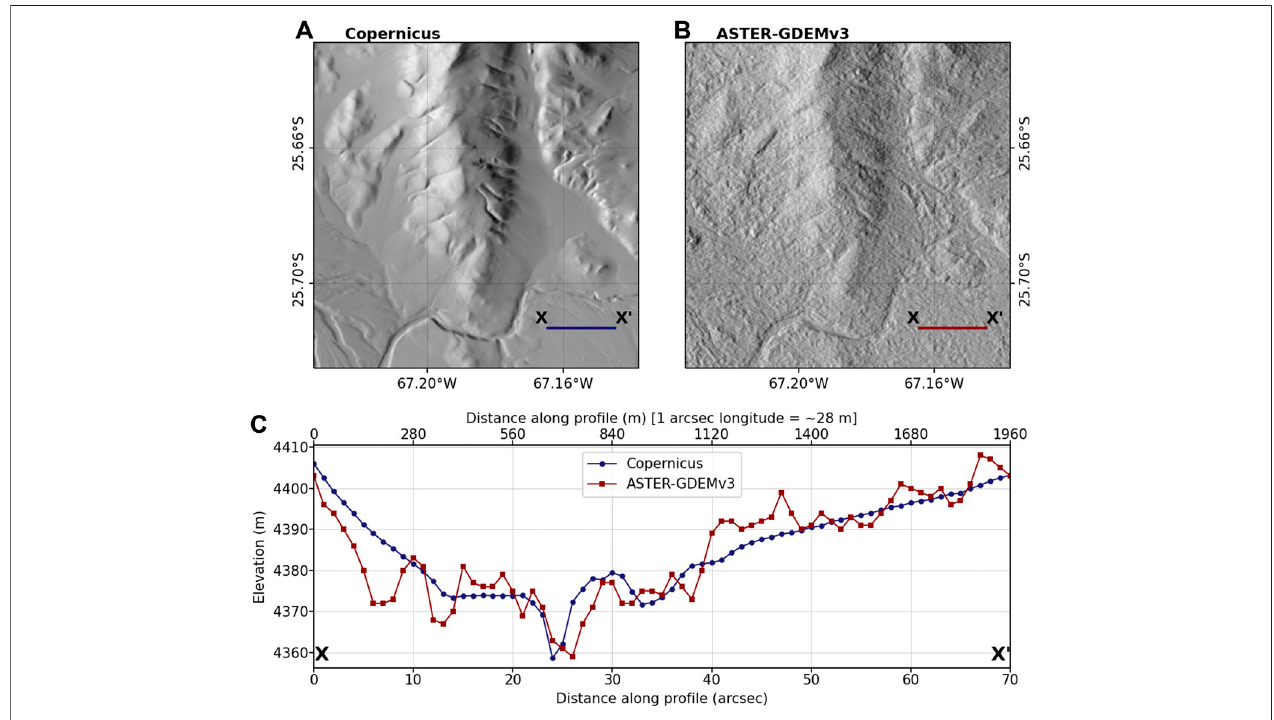
FIGURE 2 | Example hillshades and elevation pro fi les for a ∼ 10-km square tile in the Central Andes (cf. Figure 1A for location). The DEMs are un-projected with 1 arcsec pixels, which translates into ∼ 28 × 30 m (longitude × latitude) pixels at this latitude. (A) Copernicus hillshade with smooth representation of topography due to highinter-pixel consistency. (B) ASTER-GDEMv3hillshadewithroughappearanceduetolowinter-pixel consistency. (C) ∼ 2000 mlongelevationpro fi lesforbothDEMs fromXtoX ’ .TheDEMshavenotbeenco-registeredoraligned,whichcanleadtooffsetssuchasthedifferenceinvalleybottomlocationaround25 arcsec.Notethe higher inter-pixel variability (low inter-pixel consistency) of the ASTER-GDEMv3 pro fi le.